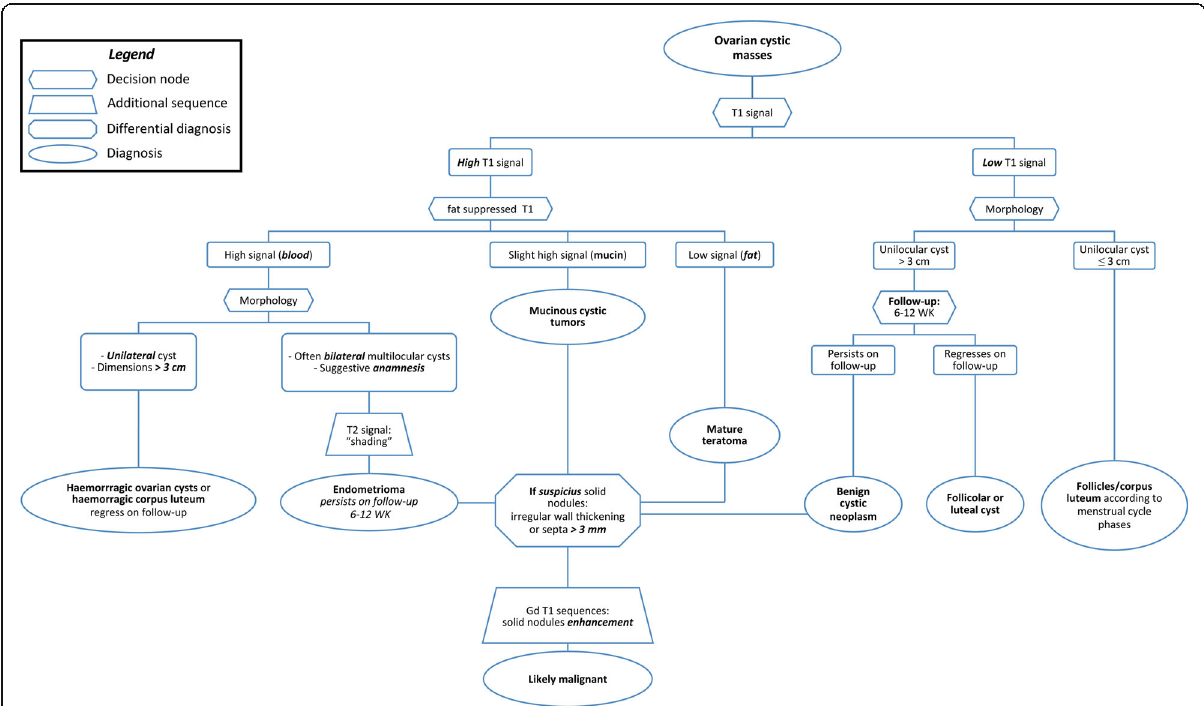
Fig. 8 Flow-chart showing the MRI algorithm summarising the diagnostic steps for elucidating cystic ovarian